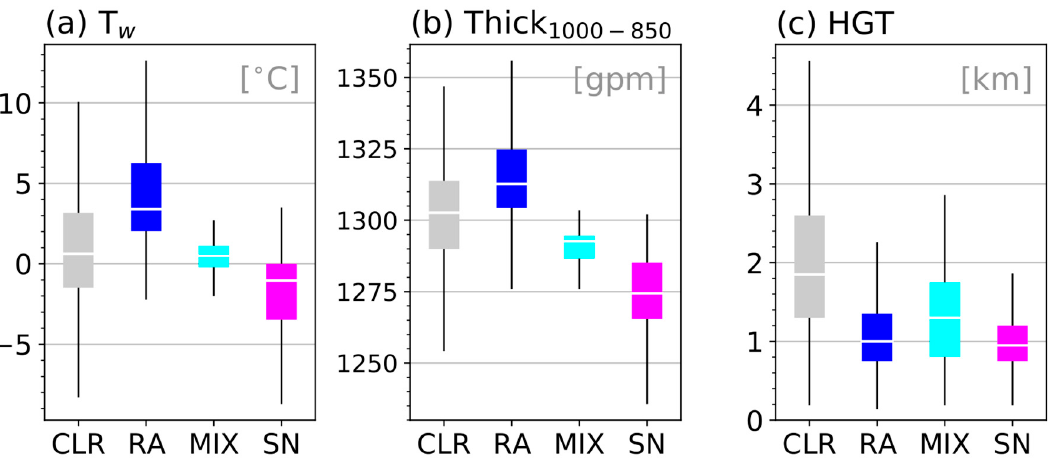
Figure 11. Boxplots of ( a ) Tw, ( b ) Thick 1000-850 , and ( c ) HGT in terms of precipitation types using training data. A white horizontal line denotes the median, with color filled box extended from the first quartile to the third quartile.